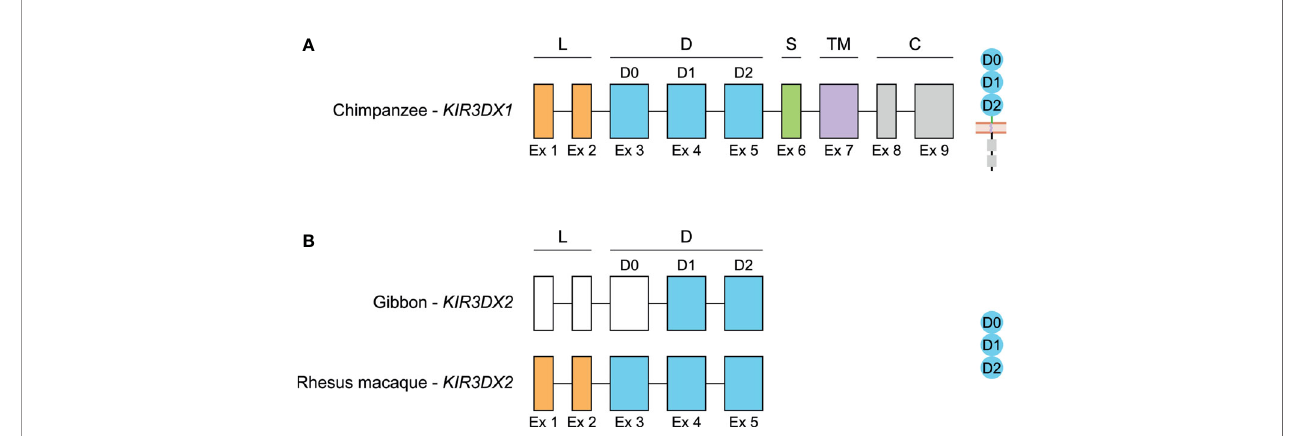
FIGURE 6 | Genomic organization of KIR3DX1 and KIR3DX2 genes in primates. Schematic illustration of the genomic organization of the chimpanzee KIR3DX1 gene that is representative for human, bonobo, gorilla, orangutan, gibbon, rhesus and cynomolgus macaque, and common marmoset (A) , and of the KIR3DX2 gene in gibbon and rhesus macaque, of which the latter is representative for cynomolgus macaque and common marmoset (B) . Exons 1 and 2, encoding the leader peptide (L), are depicted in orange; exons 3-5, encoding Ig-like domains (D), are in blue; exon 6, encoding the stem (S), is in green; exon 7, encoding the transmembrane (TM) region, is in purple; and exons 8 and 9, encoding the cytoplasmic tail (C), are in grey. Even though the start codon of gibbon KIR3DX2 is identi fi ed, the fi rst three exons could not be de fi ned, and are therefore represented by white boxes. The putative corresponding protein structures are schematically depicted adjacent to the genomic